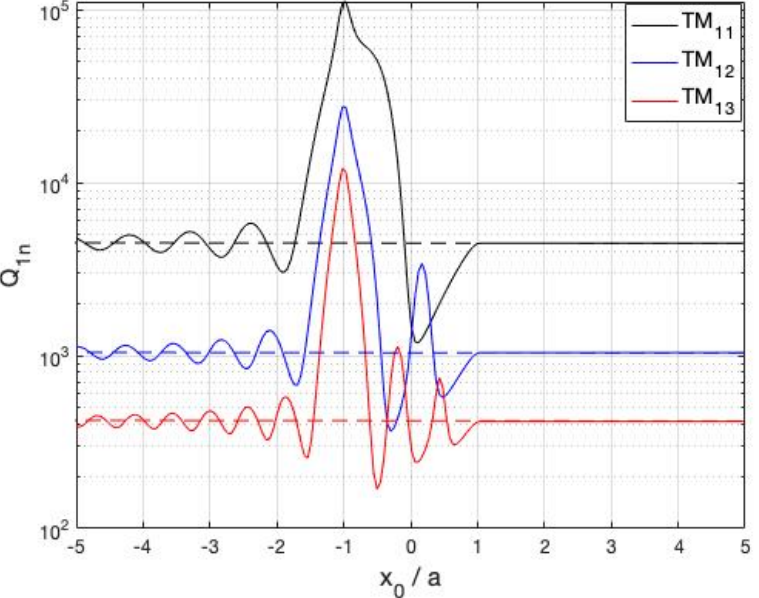
= 2, w / a = 0.25, 𝑎⁄ ( 𝑏 𝑎⁄ = 2 , 𝑤 𝑎⁄ = 0.25, and 0 / a ( b / a (cid:2868)